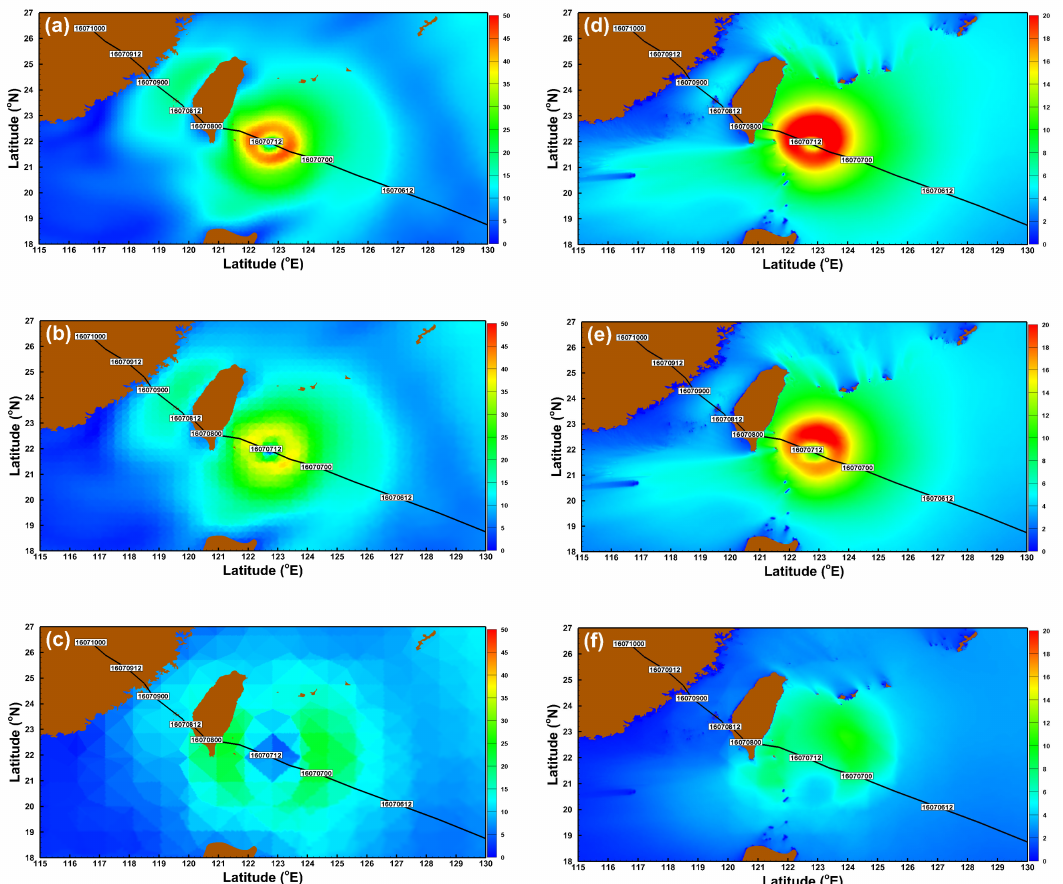
Figure 4. Instantaneous wind field distribution from the hourly Climate Forecast System version 2 (CFSV2) with spatial resolutions of ( a ) 0.205 ◦ , ( b ) 0.5 ◦ , and ( c ) 1.875 ◦ and their corresponding SWHs ( d – f ) for Super Typhoon Nepartak at 11:00 on 12 July in